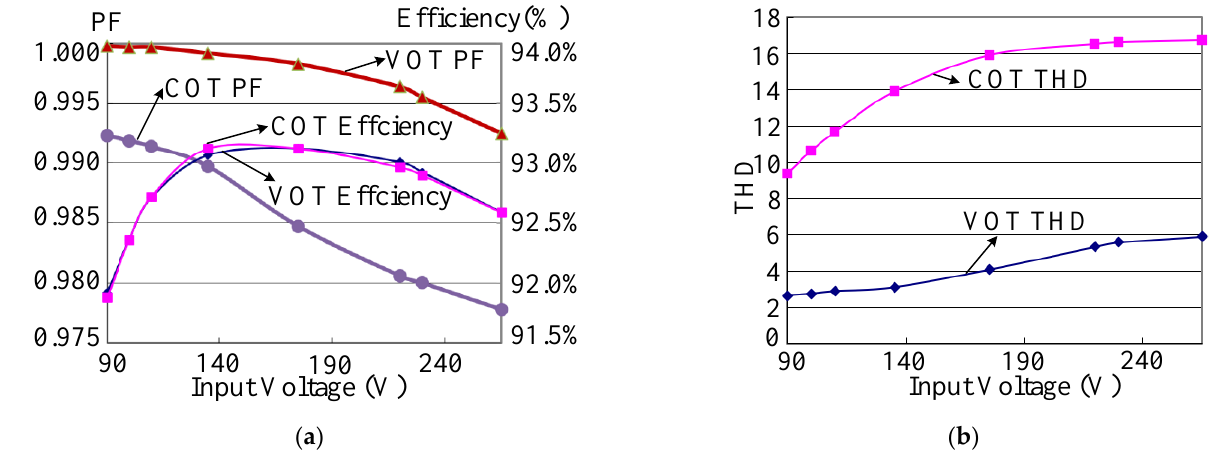
Figure 26. Experimental comparison of PF, Efficiency, and THD data with 90~265 Vac input voltage and rated 1 A output current. ( a ) PF and efficiency; ( b ) THD.